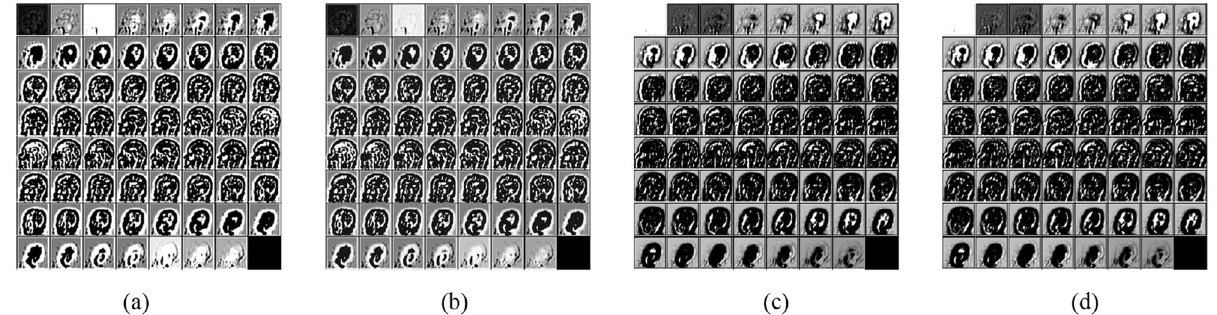
Figure 1. Comparison of activation using different functions for a sample MRI observed in 2nd activation layer (22nd of 64 channels) corresponding to 63 × 63 × 63 image as a montage from ( a ) Input ( b ) Output using SGT ( c ) Output using ReLU ( d ) Output using Leaky-ReLU. It can be observed that the output from the SGT, Fig. 1b), has well preserved the feature attribute present in the first three and last few slices in comparison to ReLU ( c ) and Leaky ReLU ( d ) where ( a ) is the input feature